Question: In a single sentence, describe what this figure presents.
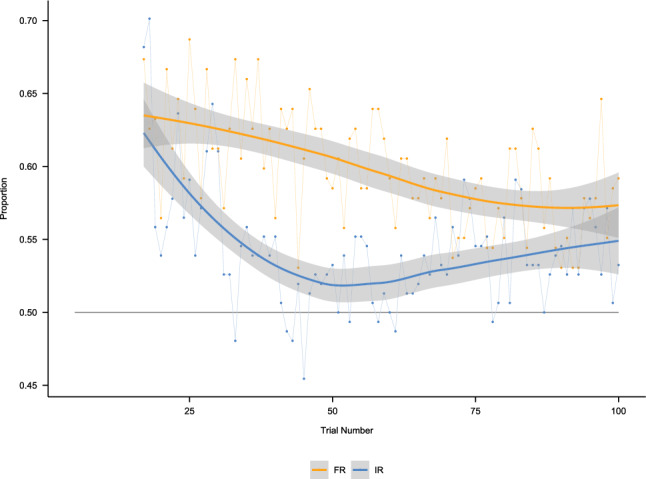
Answer: Proportion of choices for the supposed best option across trials in Experiment 2. Note. This figure represents the smoothed conditional means of the proportion of participants selecting the supposed best option in each trial. It was generated using the ‘geom_smooth()’ function from the R package ggplot2 (Whickham, 2016 ) and does not depict the linear models estimated for this dataset